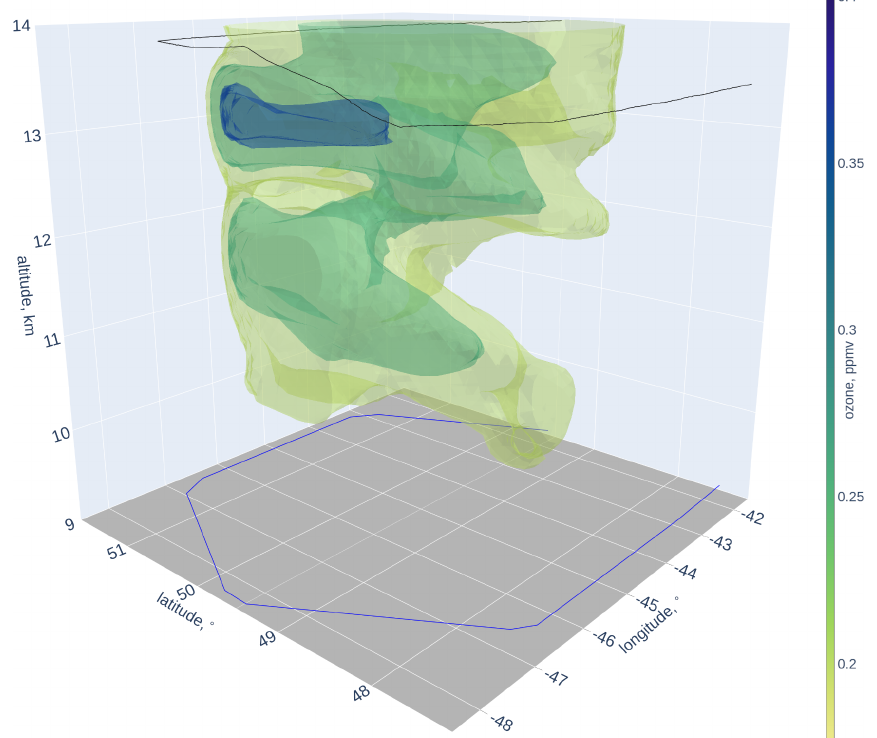
Figure 6. 3-D plot of tomographic retrieval of ozone VMR. The flight track is represented by a thin black line; a horizontal projection of the flight track is represented by a thin blue